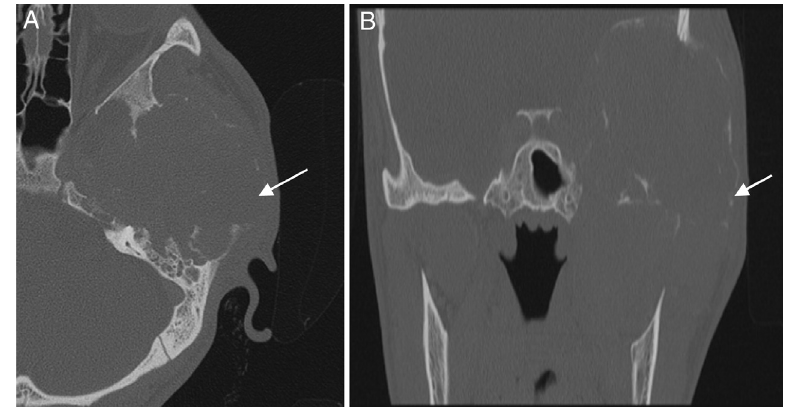
Figure 2 (A and B) High resolution axial and coronal CT image of left temporal bone reveals extensive cortical destruction involving left greater wing of sphenoid, squamous part and anterior margin of petrous part of left temporal bone. The mastoid air cells are eroded with opacification of mastoid air cells. The middle ear cavity and ossicles are completely destroyed by the mass. Note the extremely thin shell of bone outlining the lesion